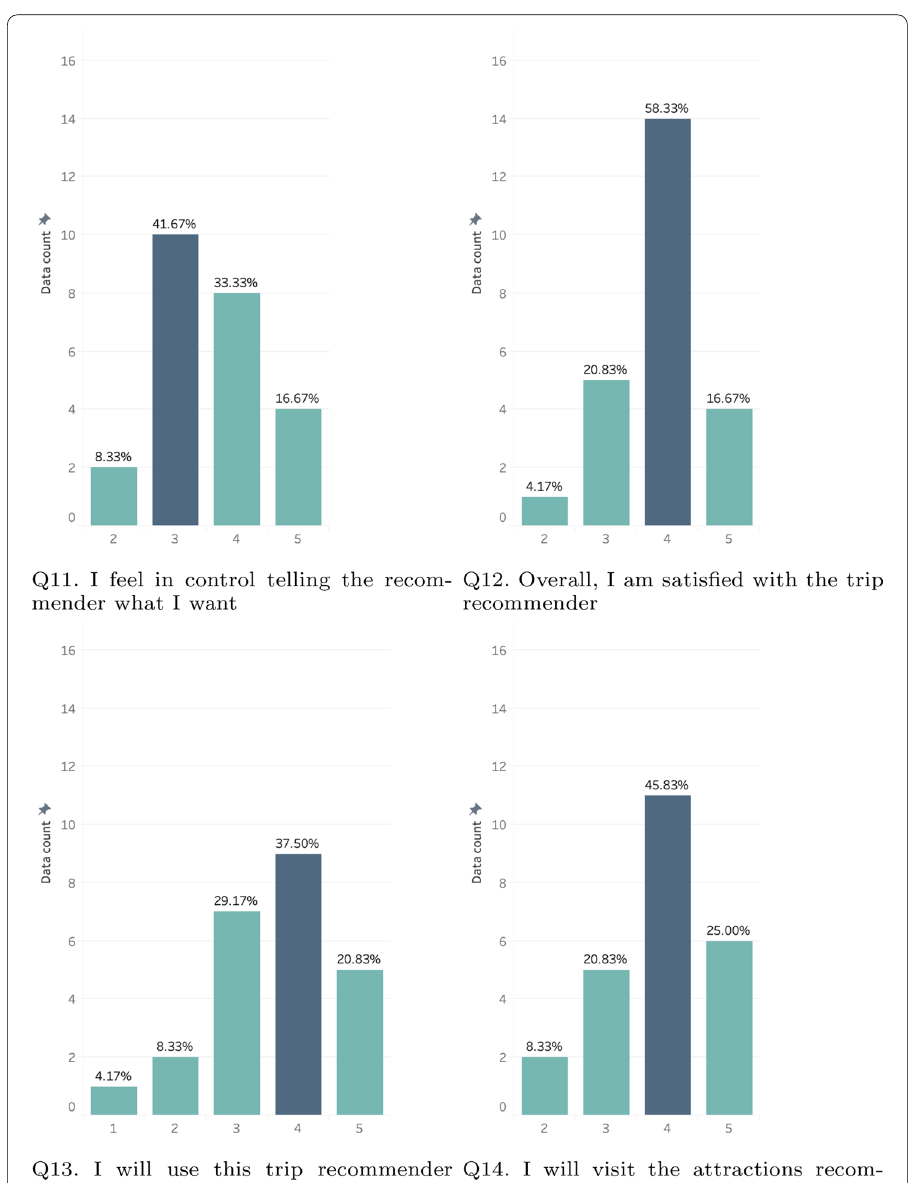
Fig. 16 Questionnaire result